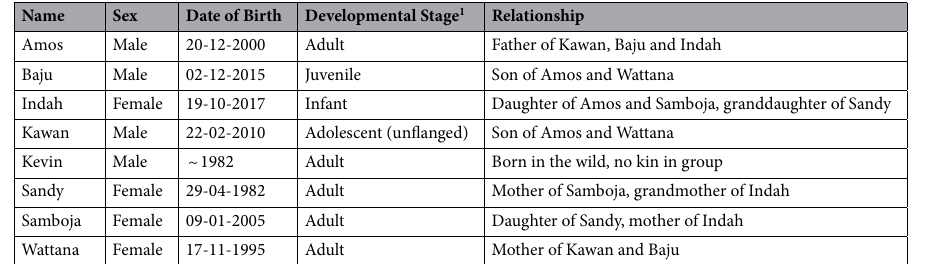
Table 1. Overview of test subjects, their sex, age, and relationship. 1 At start of experiment (January 2019).